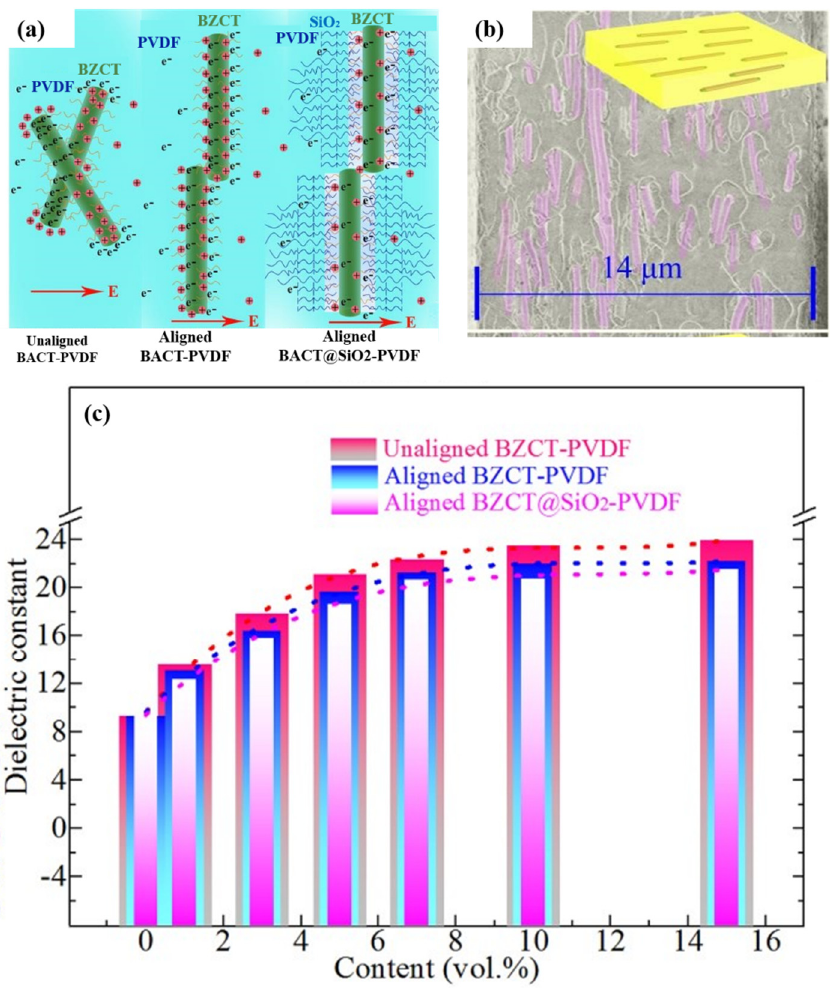
Figure 10. ( a ) Schematic illustration of polarization behavior of BZCT and BZCT@SiO 2 nanofibers. ( b ) SEM image of oriented structure. ( c ) Dielectric permittivity of composites after orientation at 10Hz. Adapted with permission [104]. Copyright 2019, Elsevier.